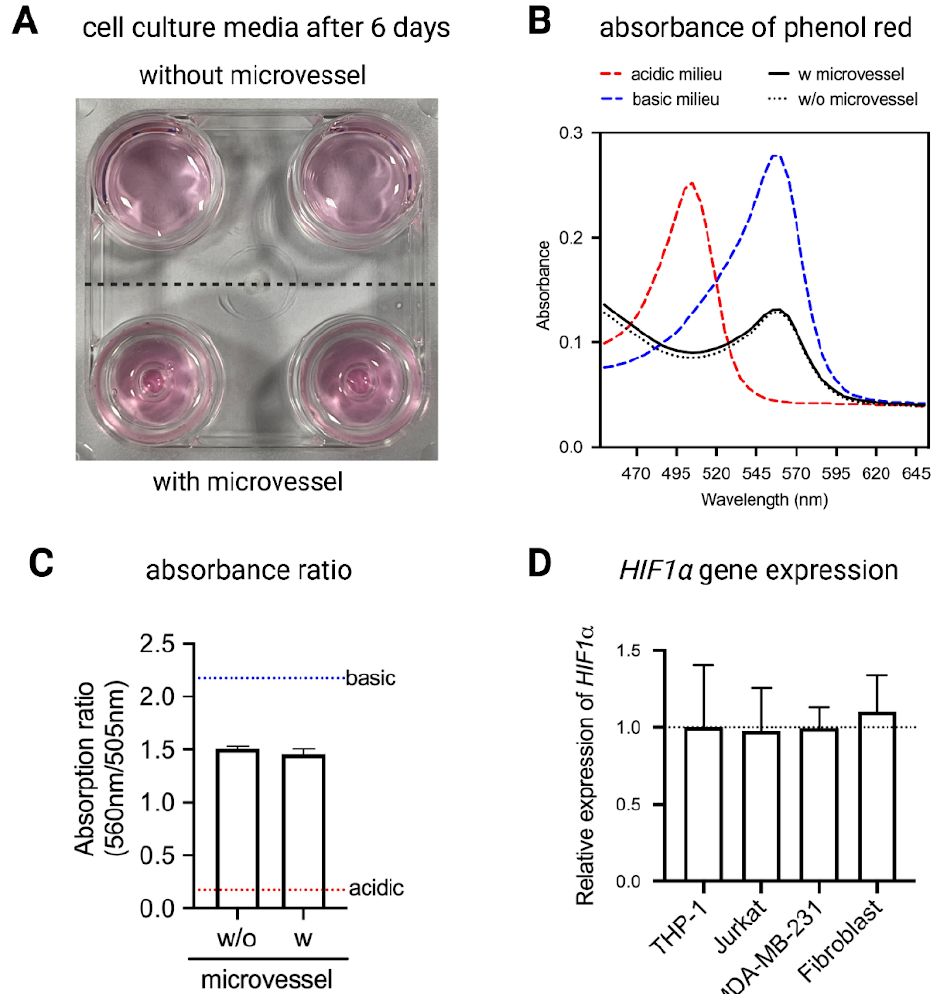
Figure 5. Gas exchange adequacy of microvessels. ( A ) Representative image of cell culture media after 6 days of culture with and without microvessels. ( B ) Absorbance of phenol red in cell culture media and ( C ) absorbance ratio (560 nm/505 nm) of phenol red in cell culture media. ( D ) Expression of HIF1 α levels in THP-1, Jurkat, MDA-MB-231 and Fibroblast cells cultured with PDMS microvessels relative to control samples cultured without microvessels. Data are presented as mean ± SD. Experiments were performed in at least 4 replicates.